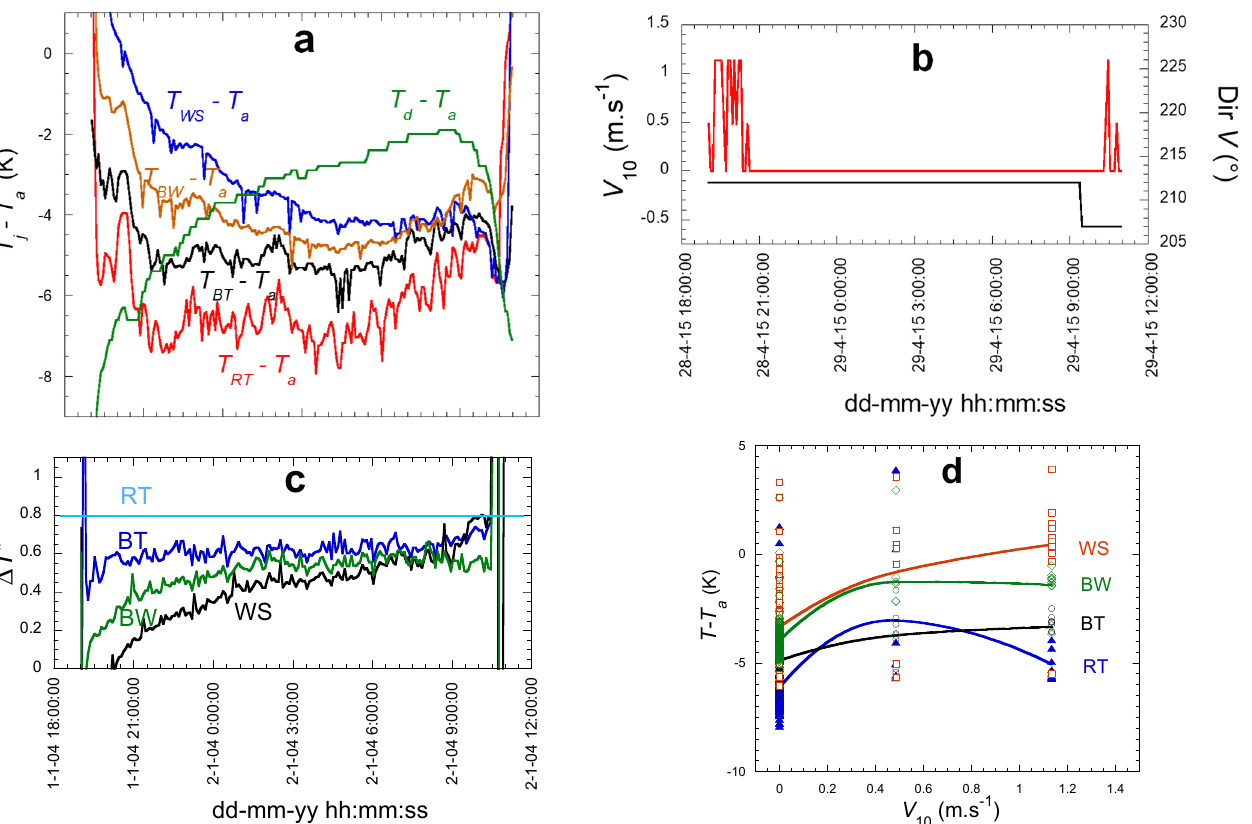
Figure 10. Recorded data from rooftop RT, back trunk BT, windshield WS, back window BW of the DC car in Valparaiso during the night 28–29 April 2015 (hh:mm:ss, UT-3). ( a ) Differences with air temperature T a of the temperatures of rooftop ( T RT ), back trunk ( T BT ), windshield ( T WS ), and back window ( T BW ). ( b ) Corresponding windspeed V and wind direction Dir V . ( c ) Cooling efficiency ratio ∆ T ∗ , ∆ T ∗ , ∆ T ∗ and ∆ T ∗ . Roof top value is, by definition, constant and equal to 0.8 (Equation (3)). ( d ): Roof top, back trunk, windshield, back window cooling ( T − T a ) as a function of windspeed V 10 extrapolated at 10 m from the ground. Curves are smoothing functions. During this night, n = 3 ( ≈ 0.17 mm · day − 1 using the factor 0.056 mm · day − 1 from Section 4.3.4). The calculated dew yield using [8] of Section 4.2.2 gives (REF) h REF = 0.15 mm.